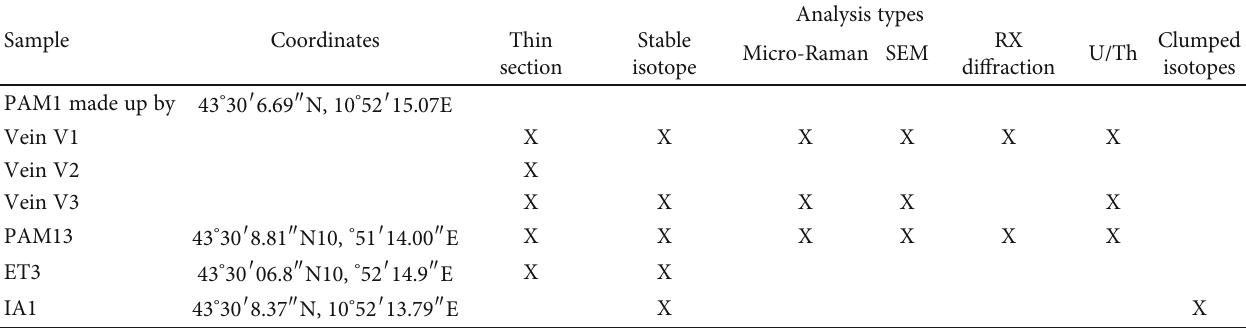
Table 1: Coordinates of analyzed samples and type of analyses run for each sample.